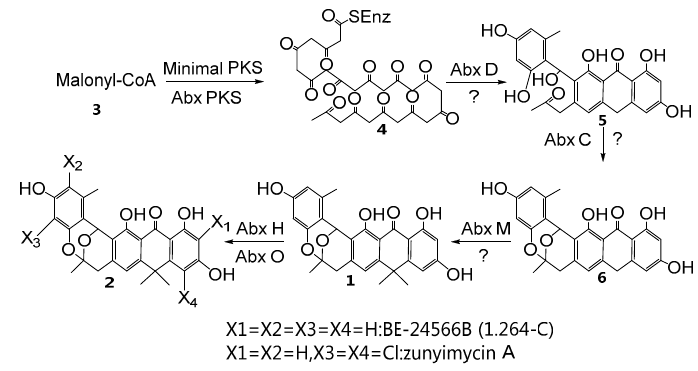
Scheme 1. Proposed biosynthetic pathway of zunyimycin A.